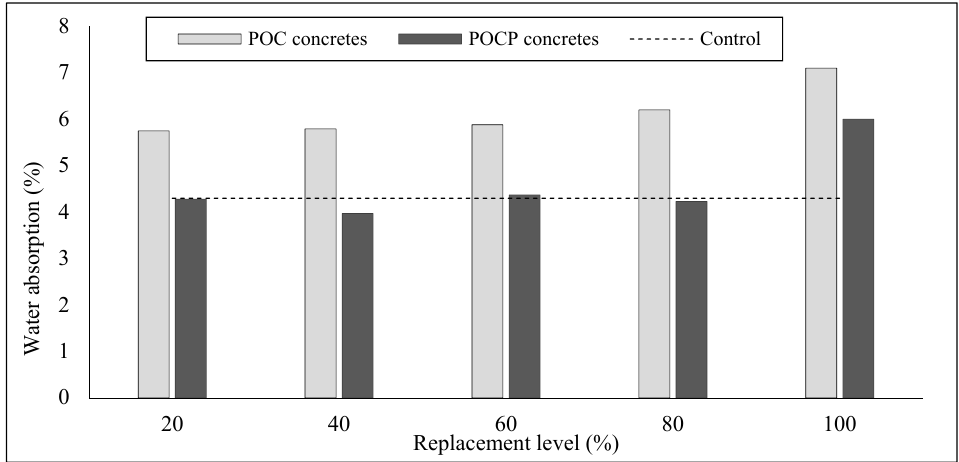
Figure 26. 28-day water absorption of POC and POCP concretes.